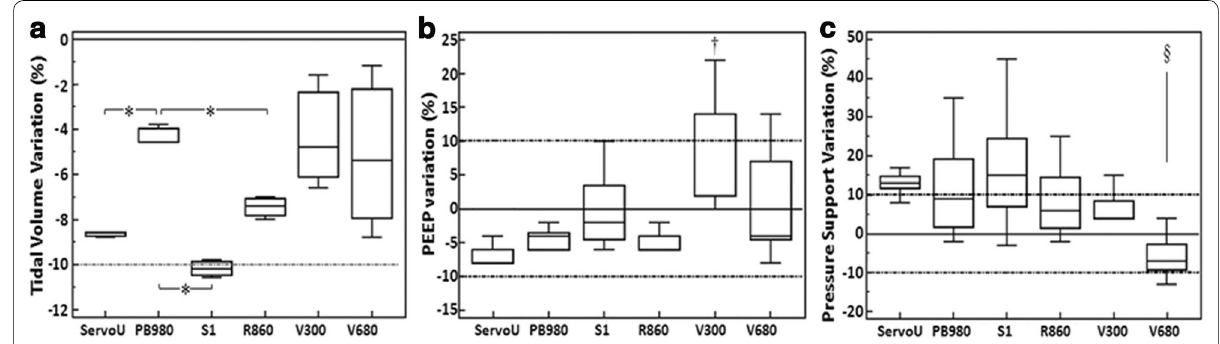
Fig. 2 Box plot of tidal volume (VT) ( a ), positive end-expiratory pressure (PEEP) ( b ) and pressure support (PS) ( c ). Dotted lines represent the 10% error range. Black line represents exact VT value delivery. Values are provided as median and interquartile. A p value equal or below 0.05 was considered significant. * p < 0.05; § p < 0.05 as compared to S1, PB980 and Servo-U. † p < 0.005 as compared to R860, PB980 and Servo-U. There was a significant difference in terms of VT delivery precision between devices ( a ; p 0.0498). All devices except S1 depicted a median VT value within the 10% error = range. PB980 had the lowest error in terms of VT delivery, but Servo-U had the highest precision in response to respiratory mechanics modifica- tions. V500 and V680 had relatively low error, but low precision in response to respiratory mechanics modifications. While median PEEP delivery was within the reliability range for all devices ( b ), V500 was significantly different to the other devices in terms of precision. S1 had the lowest error, but with rather low precision. Servo-U, PB980 and R860 had low error and high precision. When considering mean values, three devices delivered PS values higher than the reliability range (Servo-U: